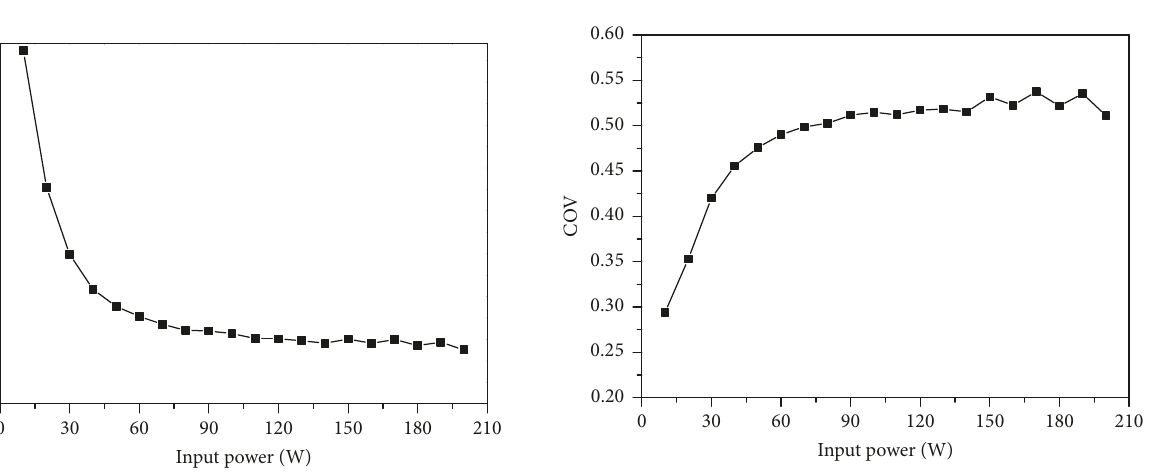
becomes worse, the same conclusion was drawn in reference